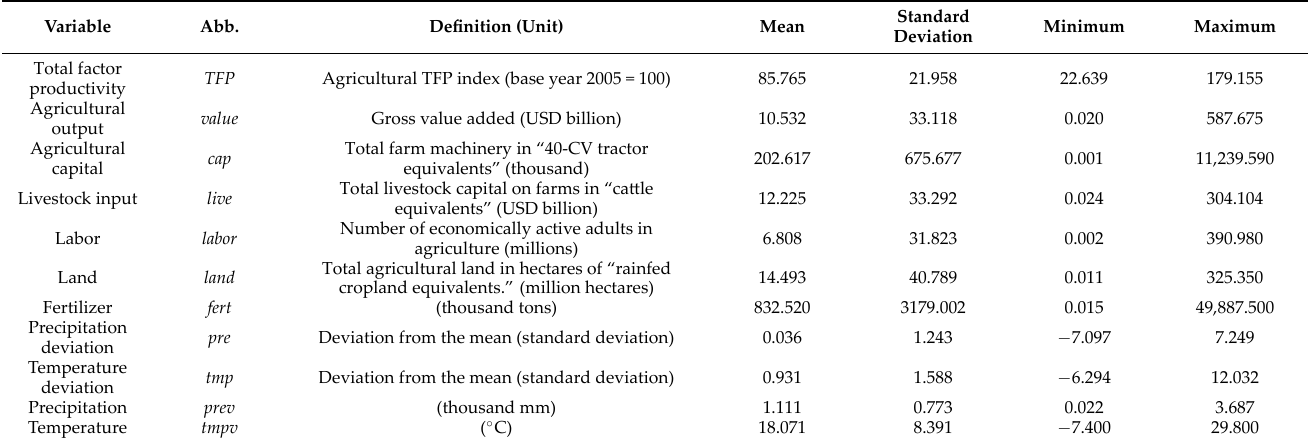
Table 2. Descriptive